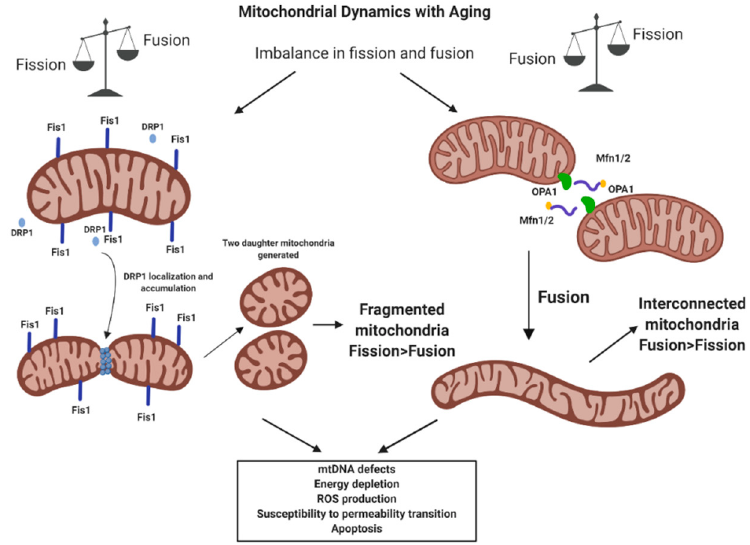
Figure 7. Schematic depicting the consequences of alterations in mitochondrial dynamics with aging.